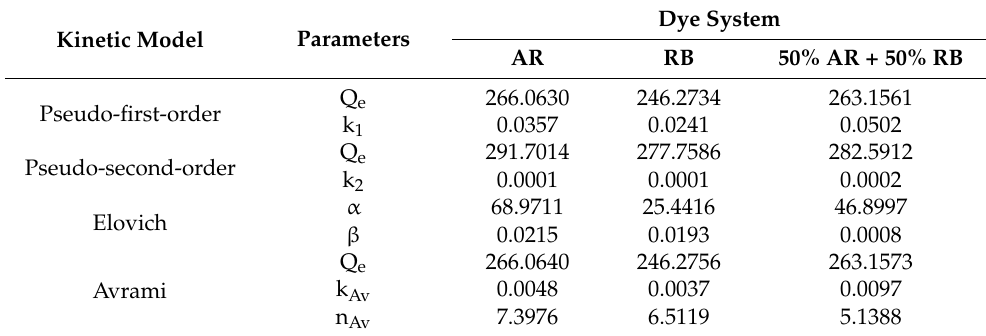
Table 3. Kinetic parameters of adsorption of AR, RB, and 50% AR + 50% RB.